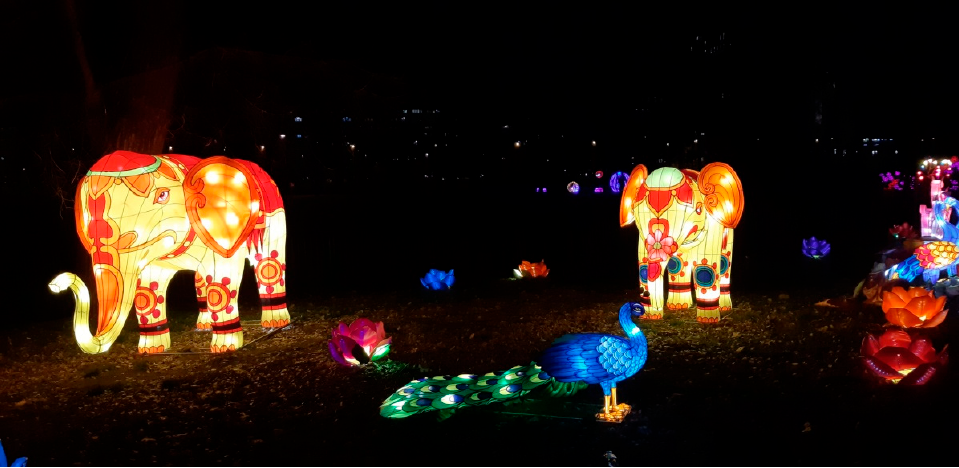
Figure 2. Chinese lanterns in the ‘Liman’ Park. Source: Bojan Đ er č an, Ferburary 2022.